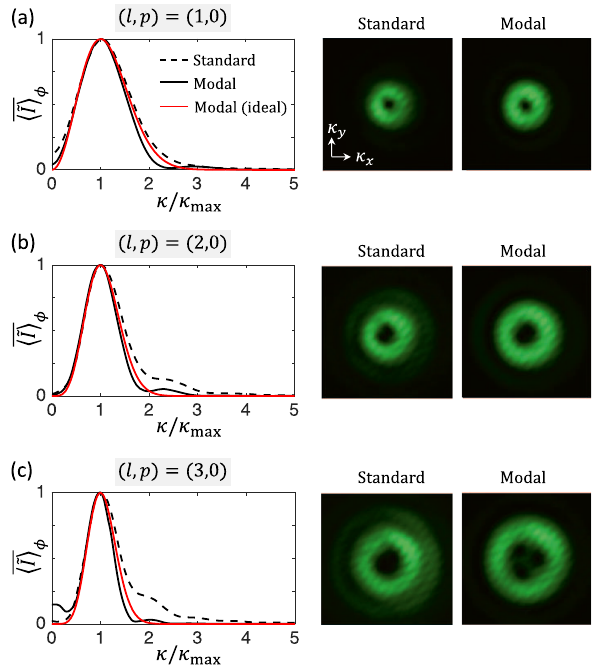
Figure 5: Reduced azimuth-average far field intensity distribution for standard and modal ( p = 0) vortex beam shapers with ( ) 1 ∕ 2 𝜅 2 + 𝜅 2 [ ⟨ ̃ I ⟩ 𝜙 ] where 𝜅 = l = (1 , 2 , 3). We define ⟨ ̃ I ⟩ 𝜙 = ⟨ ̃ I ⟩ 𝜙 ∕ max x y 𝜅 is the magnitude of the spatial frequencies in the transverse plane is the spatial frequency magnitude at which ⟨ ̃ I ⟩ 𝜙 is and 𝜅 max maximum. The data is recorded by placing a lens with focal length f = 50 cm in f – f configuration between the sample and the camera. The experimental far field intensity distributions are shown on the right part of the figure and are all displayed using identical scale.